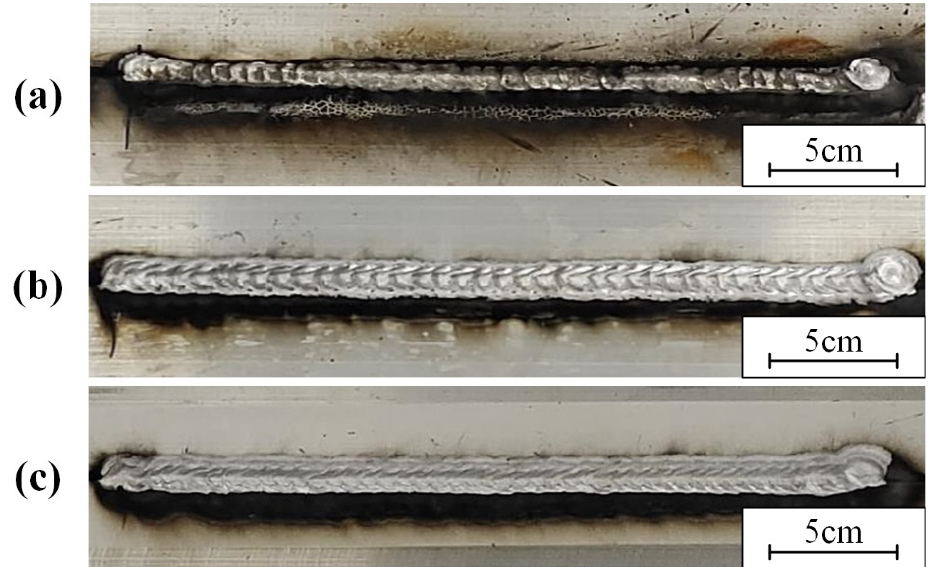
Figure 10. The weld formation on sample with: ( a ) oil; ( b ) water; ( c ) laser cleaning.